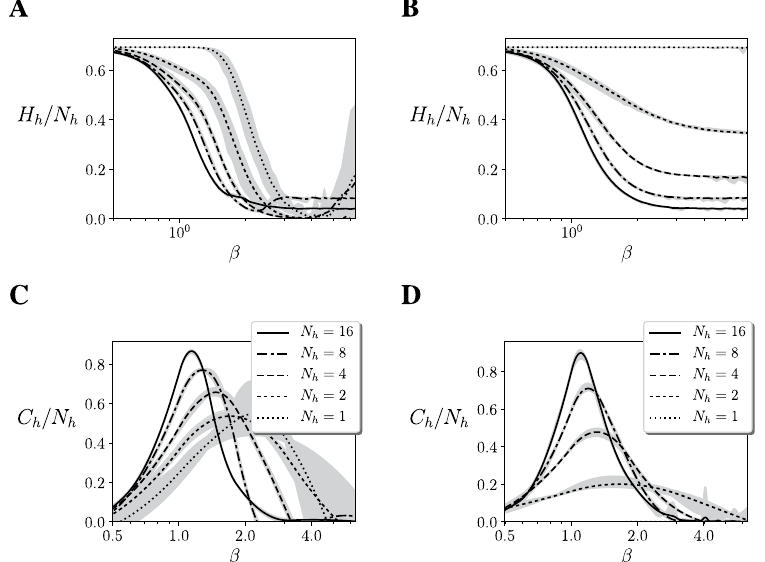
Figure 4. (A , B) Entropy of the agent’s neural controller for different sizes up to N = 22 ( N h = 16), for 10 different agents and 101 values of β . (C,D) Heat capacity of the agent’s neurons. Heat capacity computed as ∂ β β = − β C ( ) H ( ) , where H ( β ) is estimated using B-splines. Maximum and minimum values are shown by the ∂ β grey area. The figures suggest that in both the Mountain Car (left) and Acrobot (right) embodiments the model presents a divergence of its heat capacity as the number of neurons N increases, suggesting that the neural controller of the system is near a continuous phase